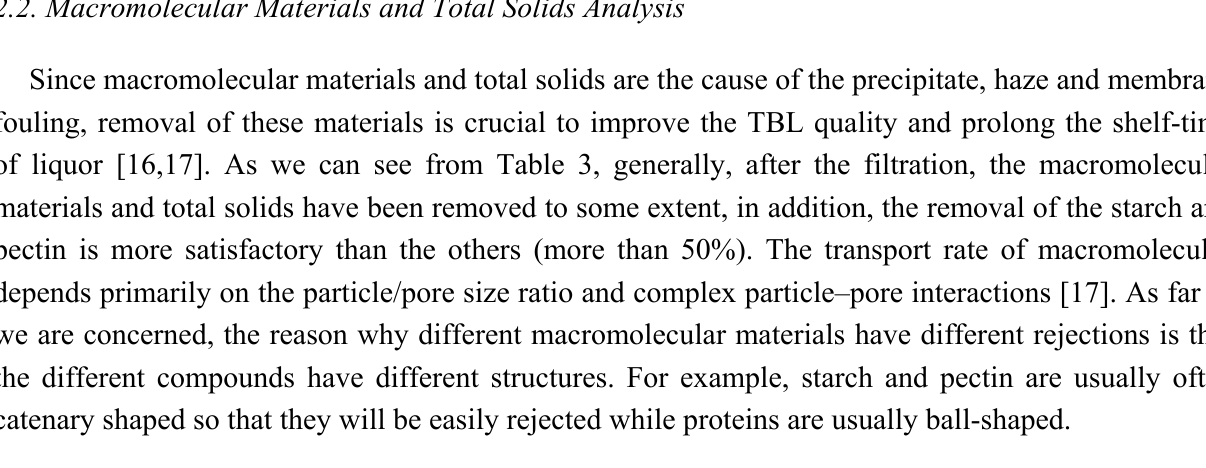
Table 3. Removal of macromolecular materials and total